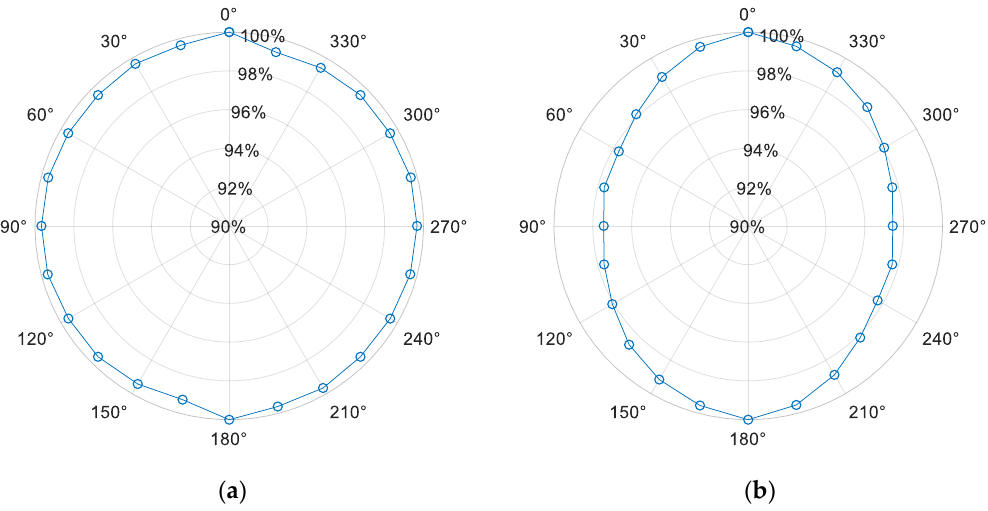
Figure 8. Surface wave velocity distributions of the two specimens: ( a ) Hot rolled specimen (SA.1); ( b ) Extruded specimen (SB.1).